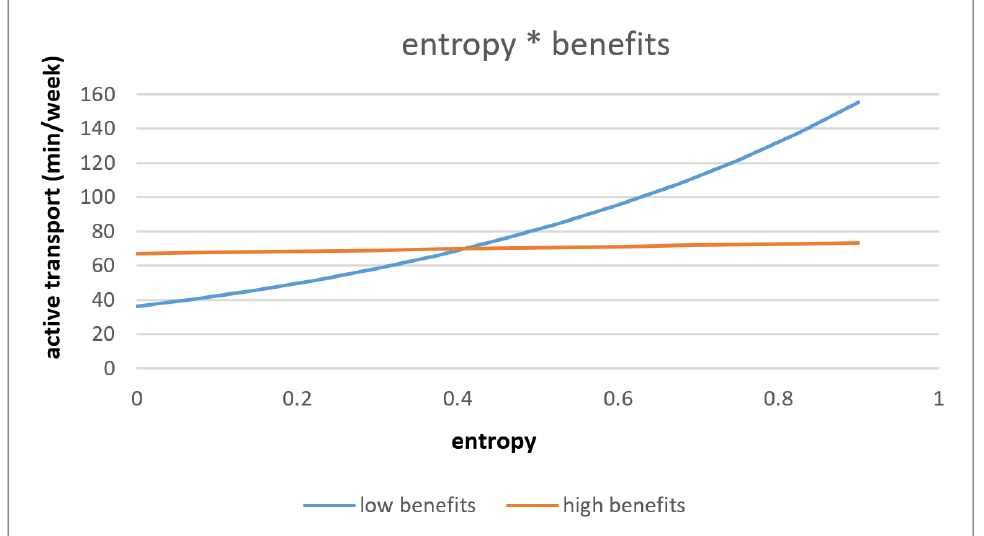
Figure 6. Interaction effect of entropy and benefits towards PA on active